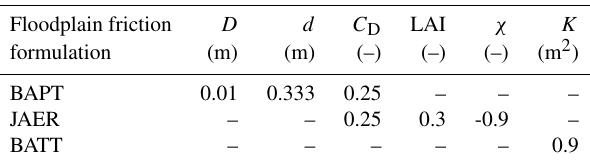
Table 2. Floodplain friction parameter values calibrated under sub- merged conditions ( H = 1 .